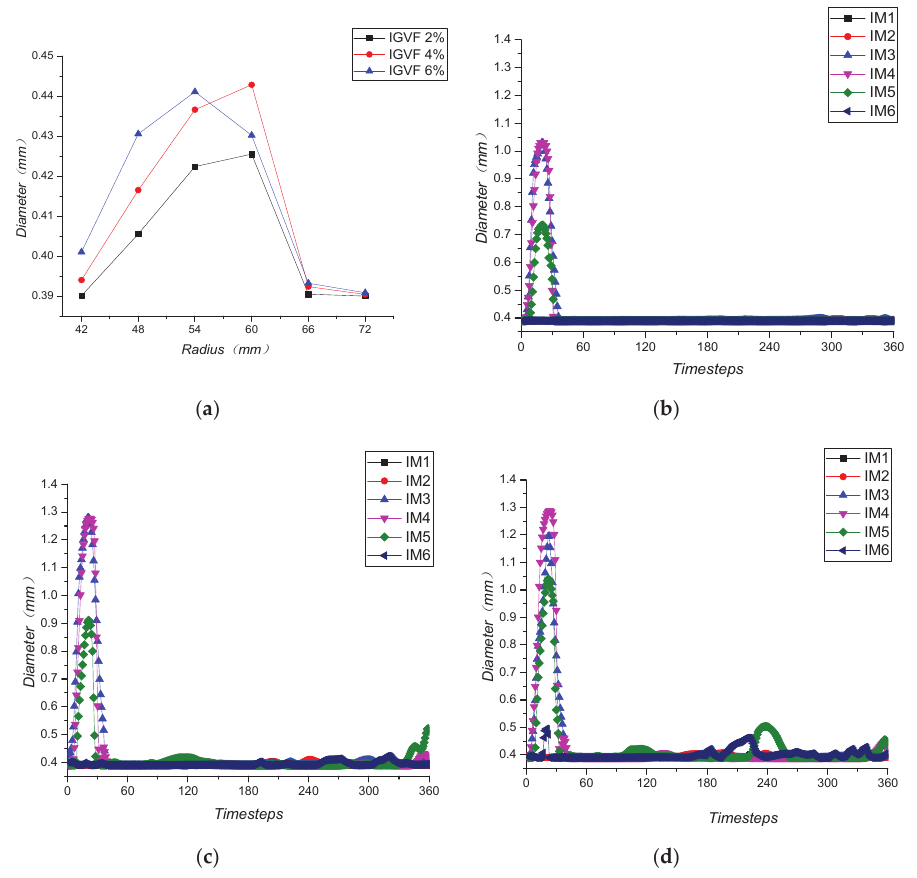
Figure 20. Diameter change under different IGVF at same angle and radius. ( a ) average, ( b ) IGVF 2%, ( c ) IGVF 4%, ( d ) IGVF